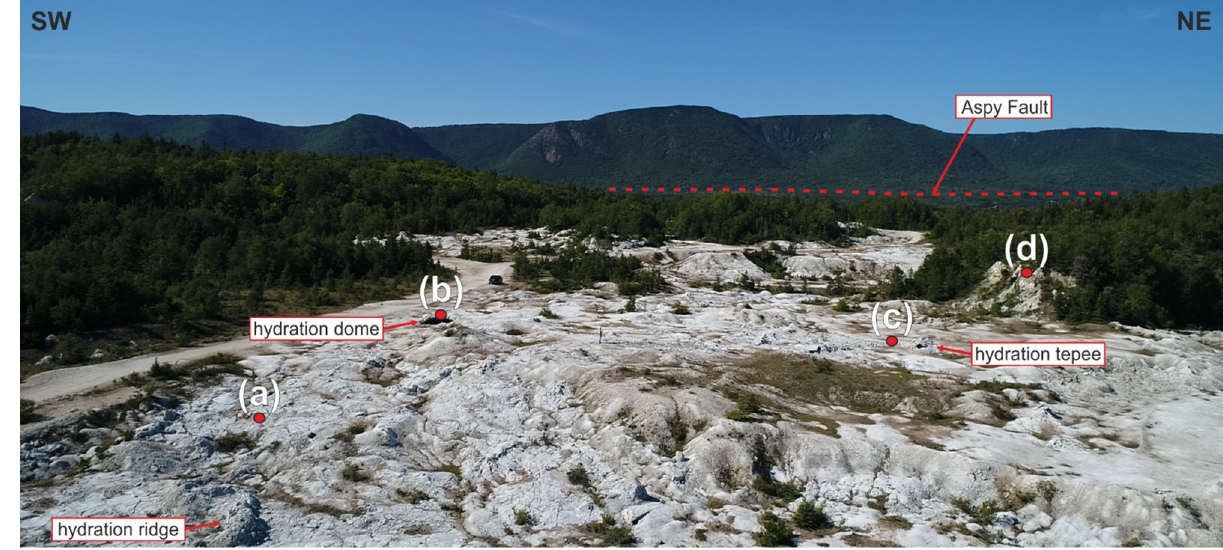
Figure 3. Relief of the expansive hydration zone developing on the anhydrite bottom of the gypsum quarry at Dingwall (north part of the central field, Figure 2) with examples of gypsification zones ( a –initial; b , c –advanced; d –mature) and rock samples typical of these zones. Content of gypsum in the rocks was determined by microscopic observation ( a , d ) and the method described by Ługowski et al. [69] ( b , c ); ( a )–sample of anhydrite collected from central part of the spheroidal weathering (cannonball) structure (from point marked by red arrow); ( b )–sample of gypsum-anhydrite rock from the detached elevated layer (from point marked by red arrow) forming ceiling of the hydration Ramesh Cave (authors, A.J., F.V., D. Ł ., as scale on the right photo taken on 24 September 2018); ( c )– sample of gypsum-anhydrite rock dug from depth of ca 70 cm at the boundary of the western range of extent of the hydration tepee with internal cave called “Personal Grotto” (from place marked by red arrow); photo taken on 28 August 2019; ( d )–sample collected 6 m above bottom of the quarry (from place marked by red arrow). Signs on the upper right side of the photos of samples: arrow– upward direction relative to the quarry bottom, X–view on the surface cut parallel to the horizontal plane. Panoramic photography of the quarry was made by author (A.J.) in September 2018 with usage of Unmanned Aerial Vehicle.